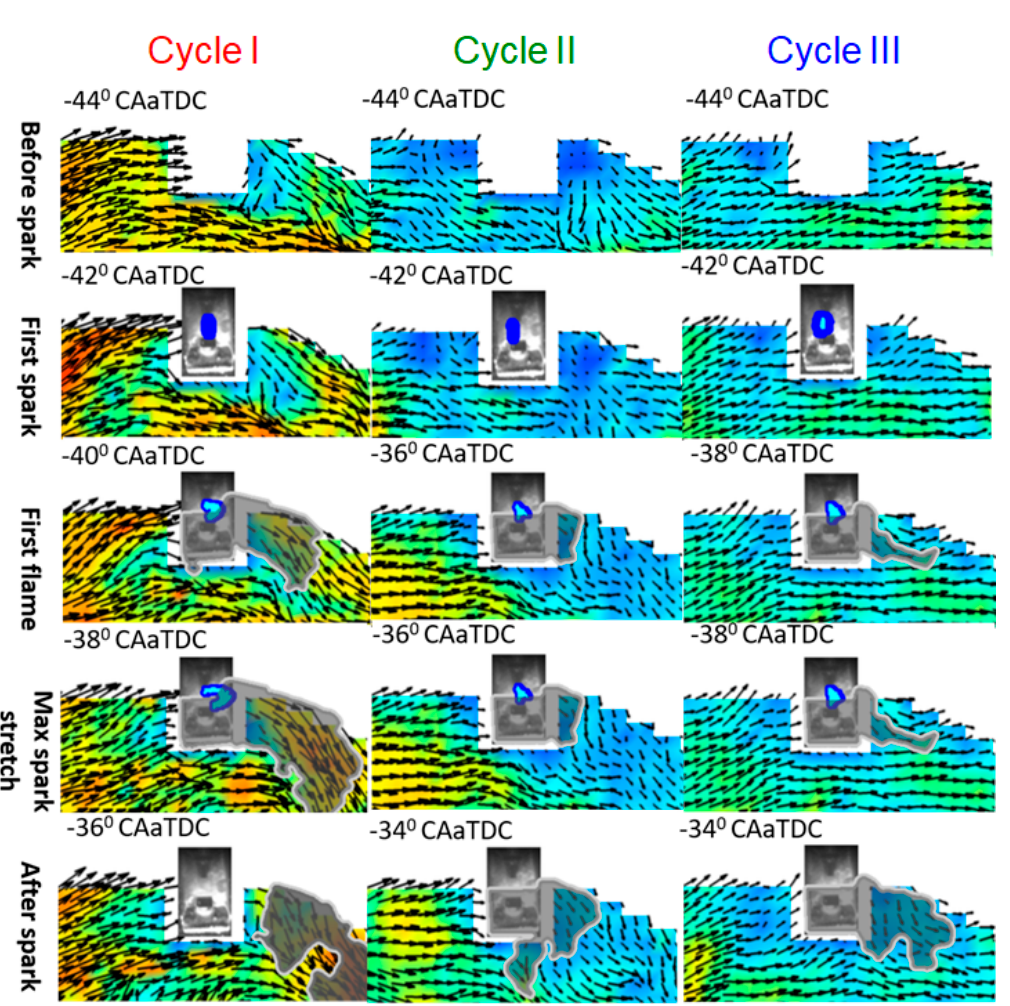
Figure 4. Near spark combined PIV-flame-spark images of three selected cycles (I, II, and III) at 1200 rpm condition.